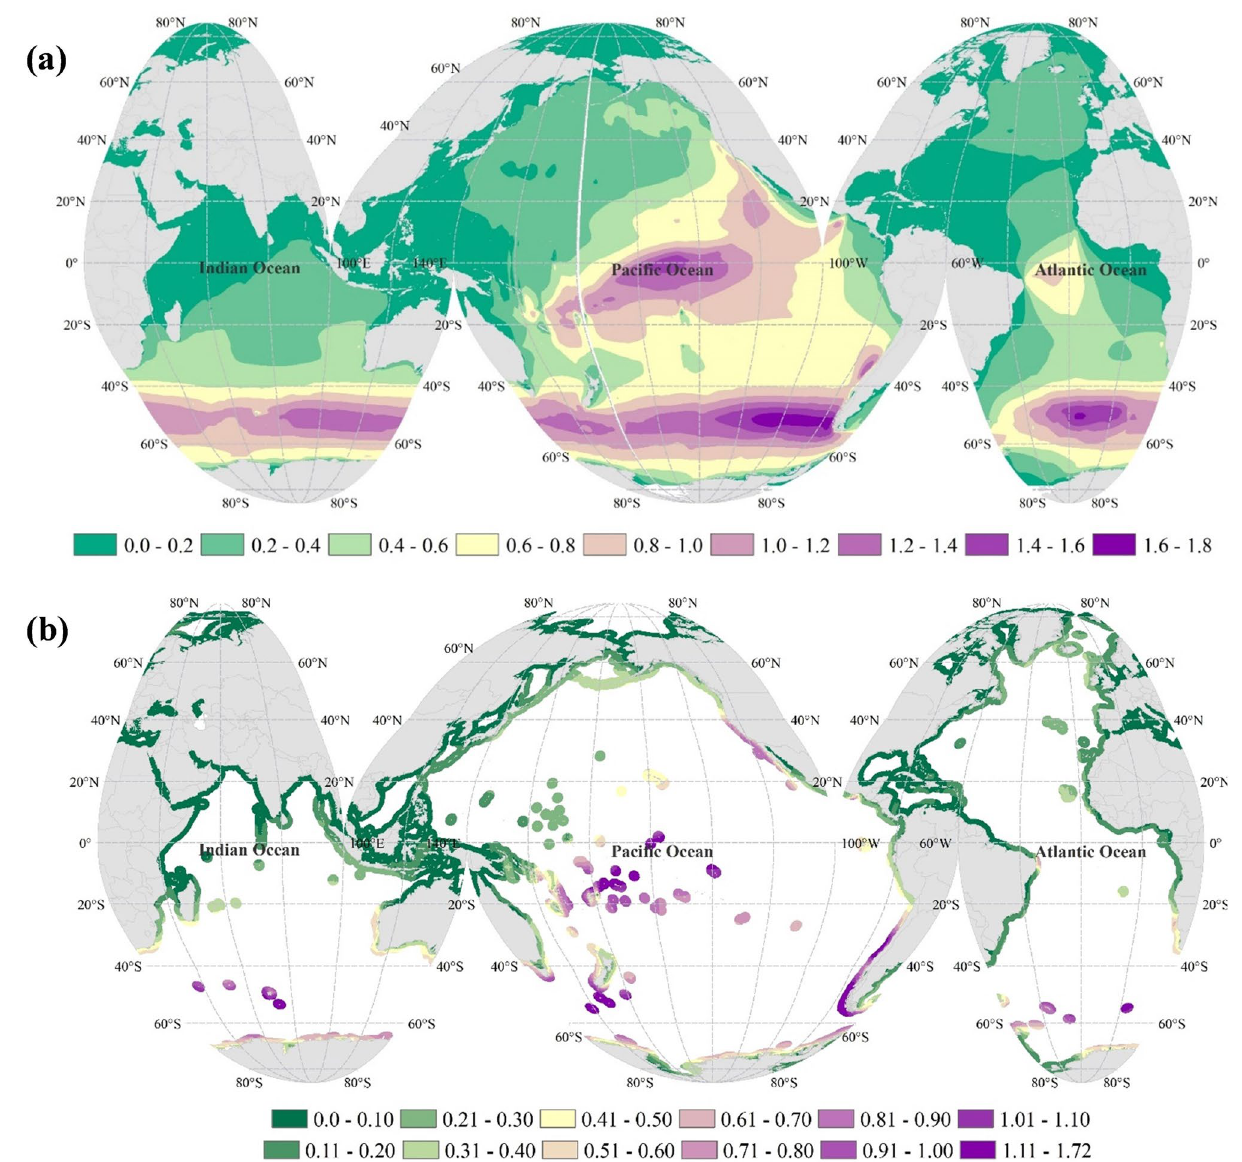
Figure 6. Sustainability Index (SI p ) ( a ) globally and ( b ) in nearshore stripes. The figure has been generated using ArcGIS 10.2 and Natural Earth-Free vector and raster map data @